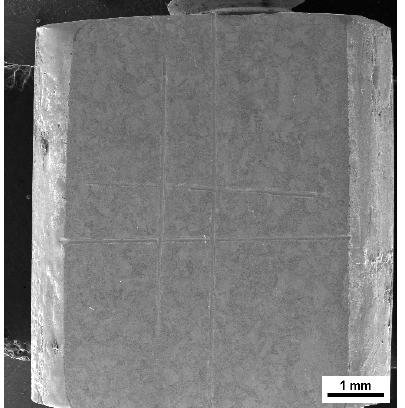
Figure 2. Location map of initial lines of raw material.